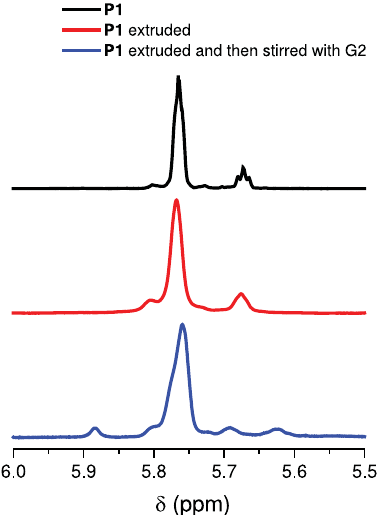
Fig. 8 | Extrusion and depolymerization of P1 . Partial 1 HNMR spectra for P1 (top, black), extruded P1 (middle, red), and extruded P1 stirred with G2 overnight (bottom, blue).